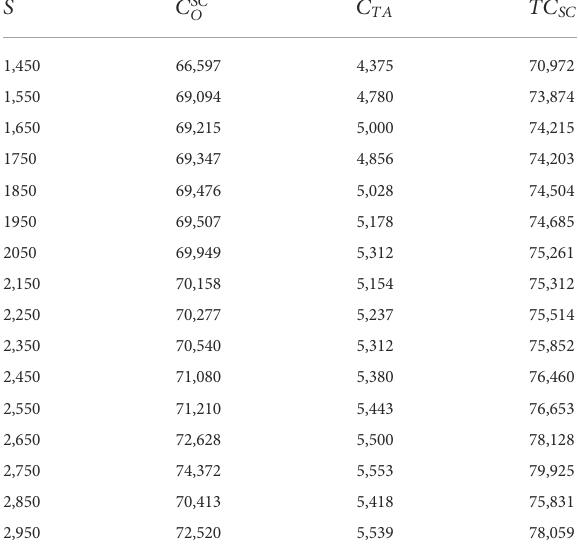
TABLE 3 Data results under the governance of carbon